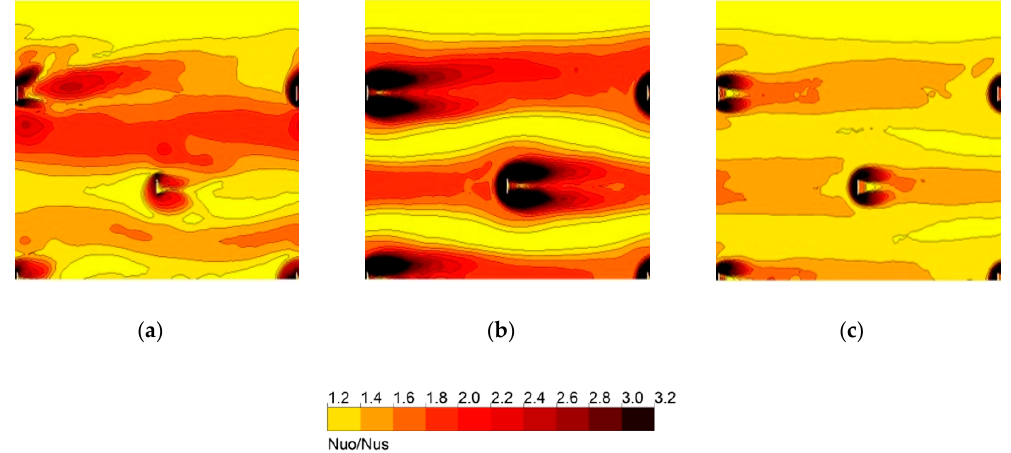
Figure 17. Variation of PF with h / e (rib area = 375 mm 2 ).